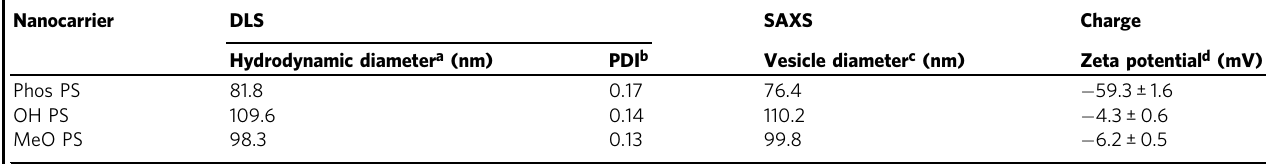
Table 1 Physicochemical characterization of PEG- b -PPS polymersome